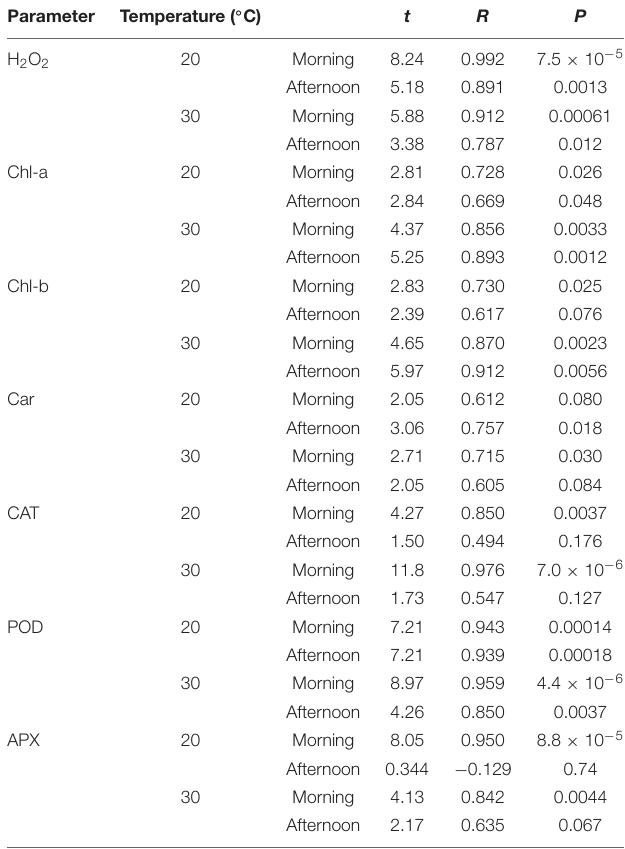
TABLE 5 | The relation of parameters with the diurnal solar radiation. Parameter Temperature ( ◦ C)